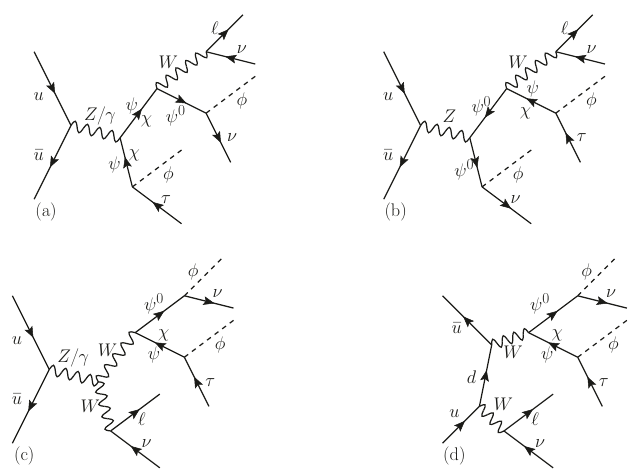
Figure 8 . Feynman diagrams contributing to the ‘ τ 2 ν 2 φ channel at the LHC. (i) The upper panel shows the Z -mediated s -channel processes through q ¯ q → ψ + ψ − , χ + χ − , ψ + χ − and ψ 0 ¯ ψ 0 channel; and (ii) the lower panel, Z -mediated s -channel as well as quark-mediated t -channel pro- cesses through q ¯ q → W W channel. The diagrams of the lower panel are seen to be suppressed, which makes the ‘ τ ν 2 φ channel predominantly Z -mediated.